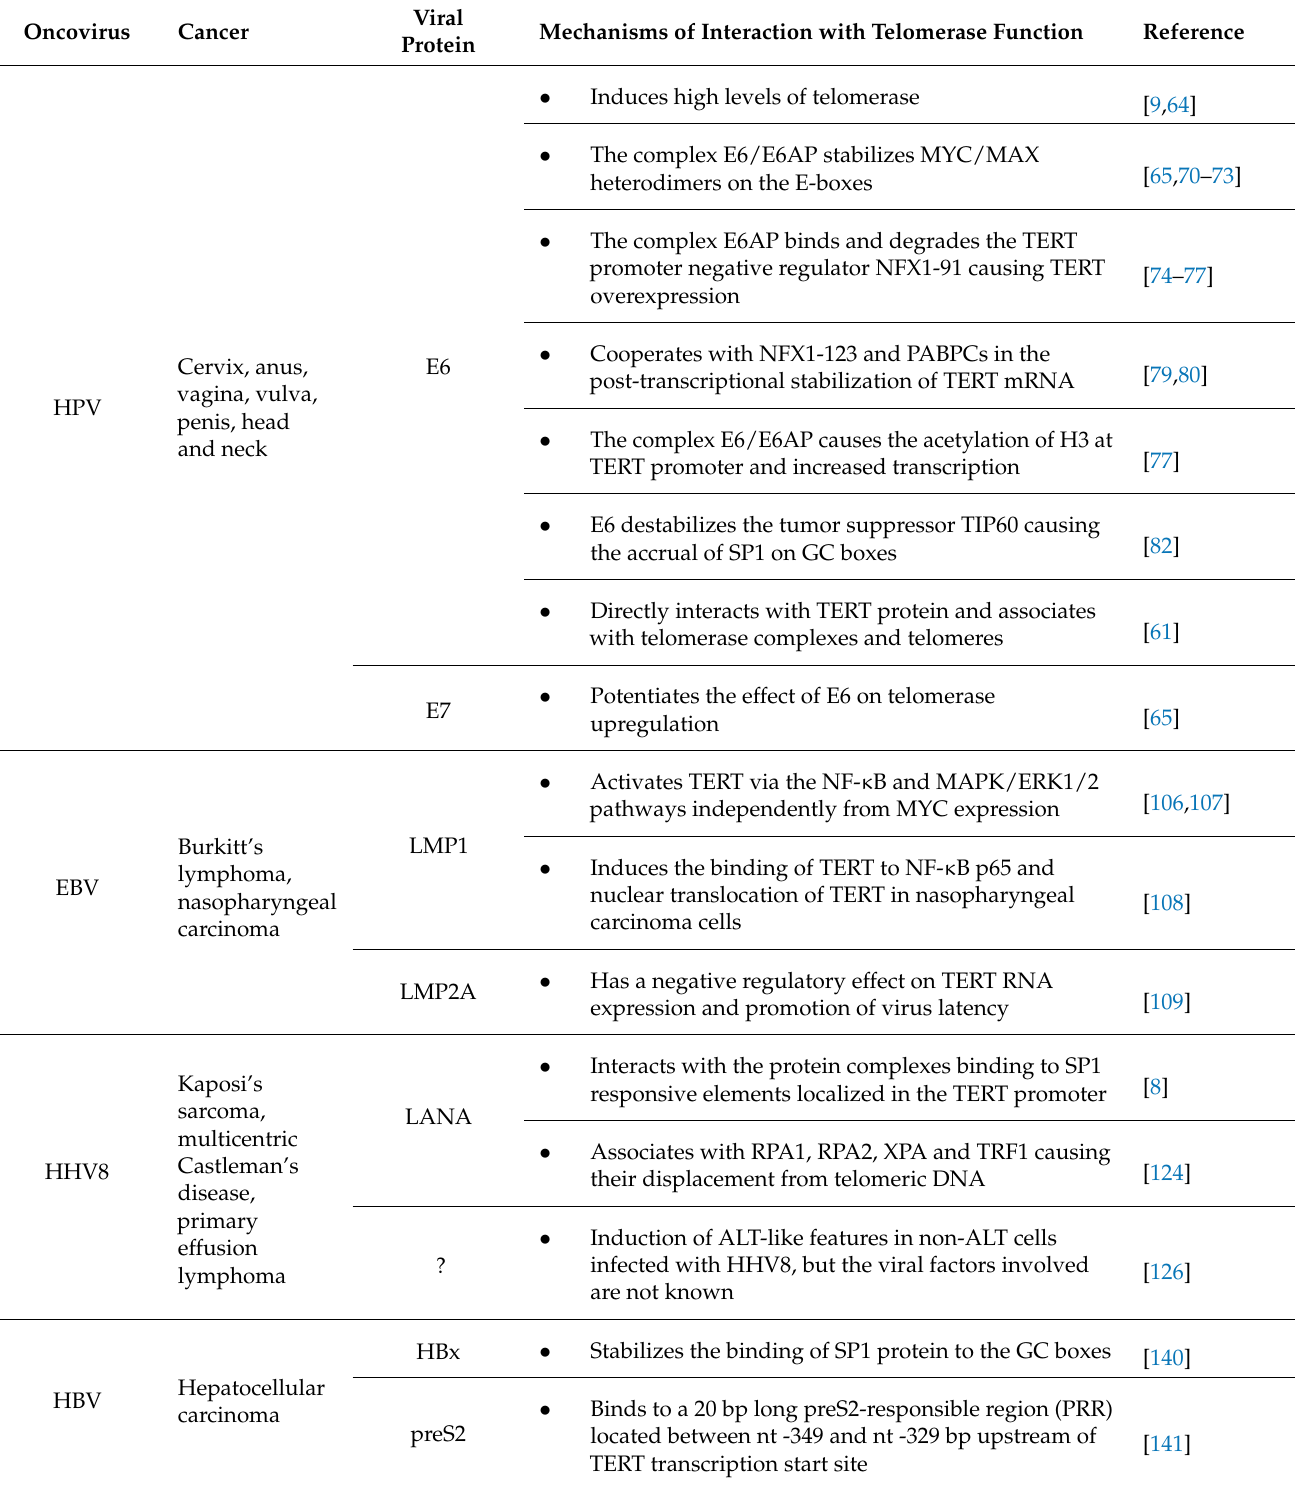
Table 1. Mechanisms of interaction between oncoviruses and telomerase in tumors associated with infectious